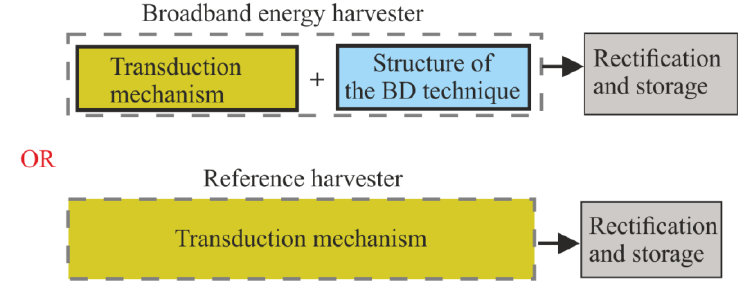
Figure 14. Broadband (BD) energy harvester versus a single reference harvester.